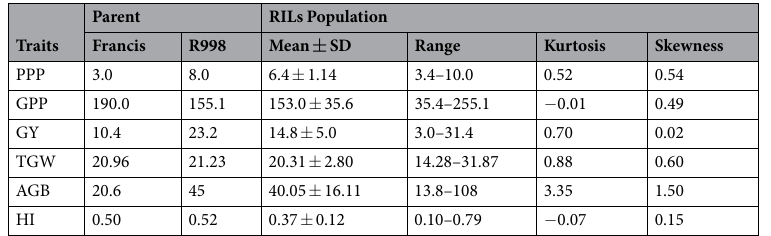
Table 2. Means of yield traits for the parental lines and the RILs